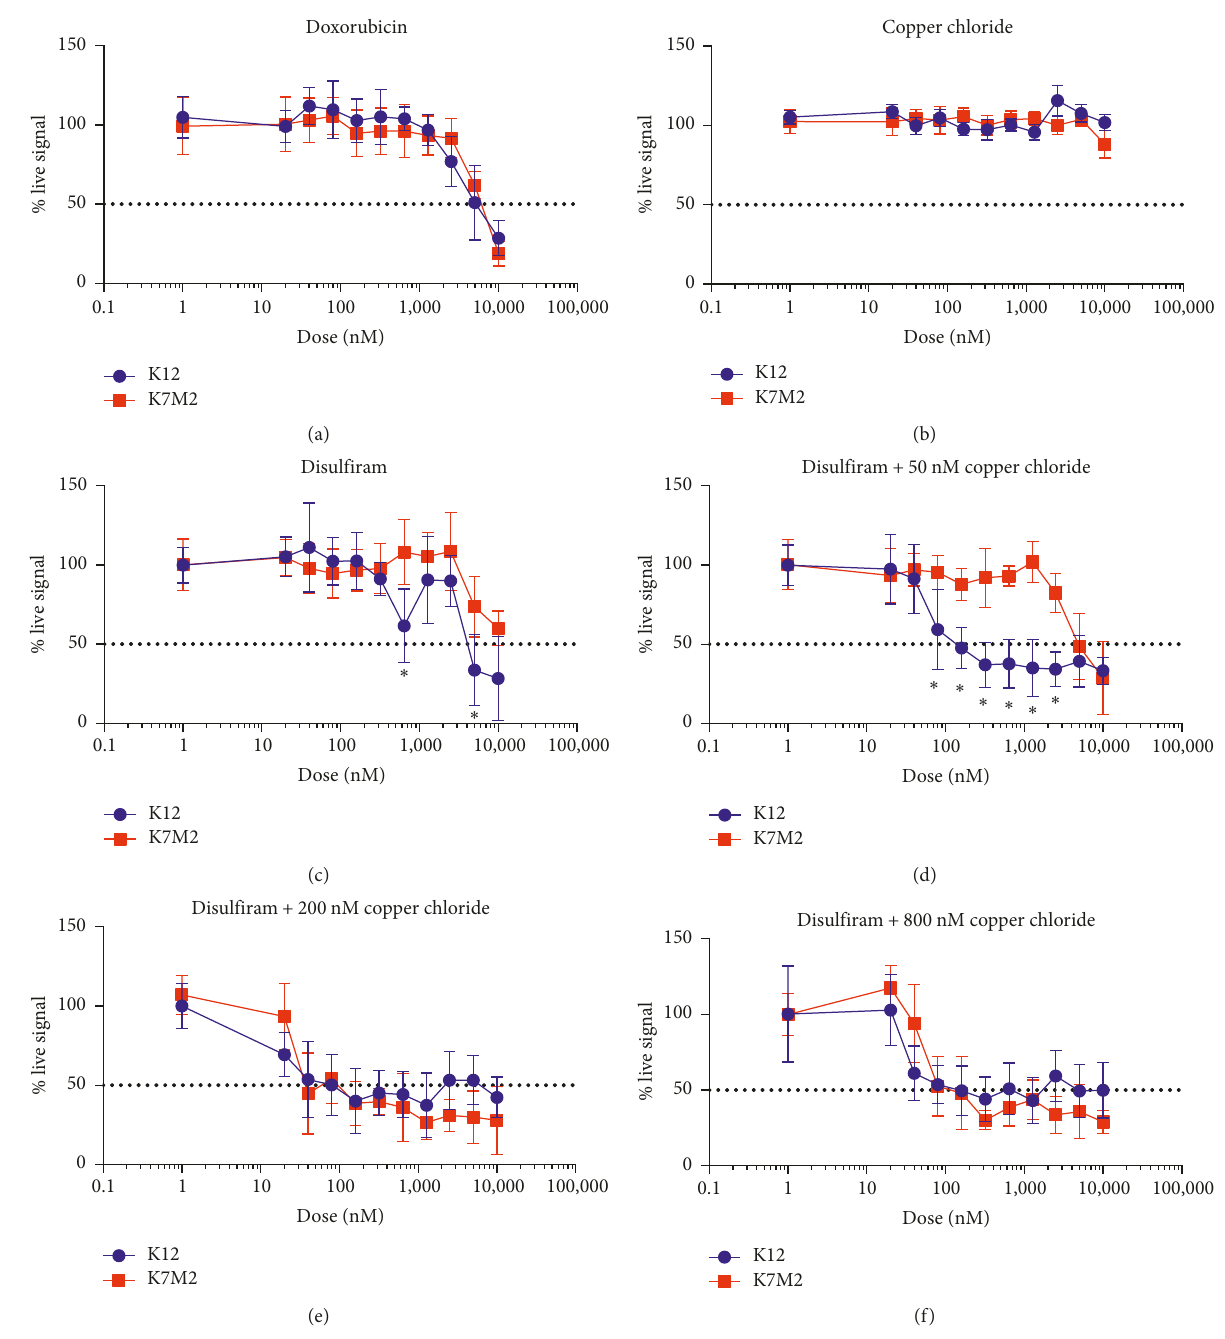
Figure 3: Copper potentiation of low-dose disulfiram selectively targets K12 cells compared to K7M2 cells. Both K12 and K7M2 cells were subjected to fold dilutions of Dox (a), CuCl 2 (b), or Dis (c) single agent treatment over 24hours. Additionally, cells were treated with fold dilutions of Dis+CuCl 2 at fixed concentrations of 50nM (d), 200nM (e), or 800nM (f). After treatment, cells were stained with LIVE/ DEAD stain, and microscopy images were obtained. Live signal reduction from untreated controls was analyzed using FIJI image mean fluorescence measurements. 50nM CuCl 2 significantly decreased the live signal % in K12 than in K7M2 from 80 nM to 2.5 μ M dose of Dis. All cytotoxicity experiments were performed in technical triplicate with three separate cell cultures ( n � 9 ) . ∗ p < 0 .